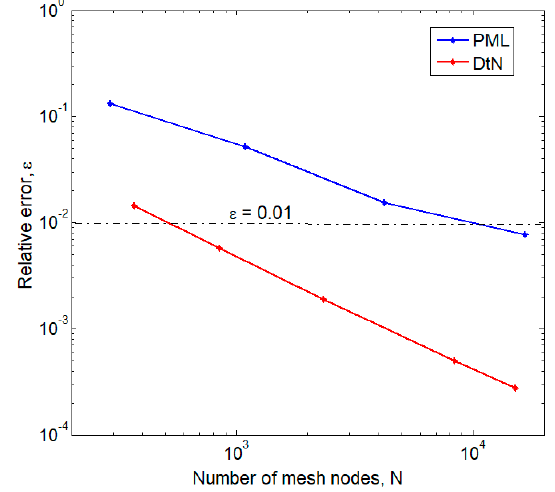
Figure 2. Case study 1. ( a ) Geometry and references for evaluating the scattering from an infinitely long conducting cylinder, illuminated by a TM z plane wave. ( b ) Map of the amplitude of the scattered field, normalized to that of the incident field. The axes x and y are normalized to the wavelength value [26].